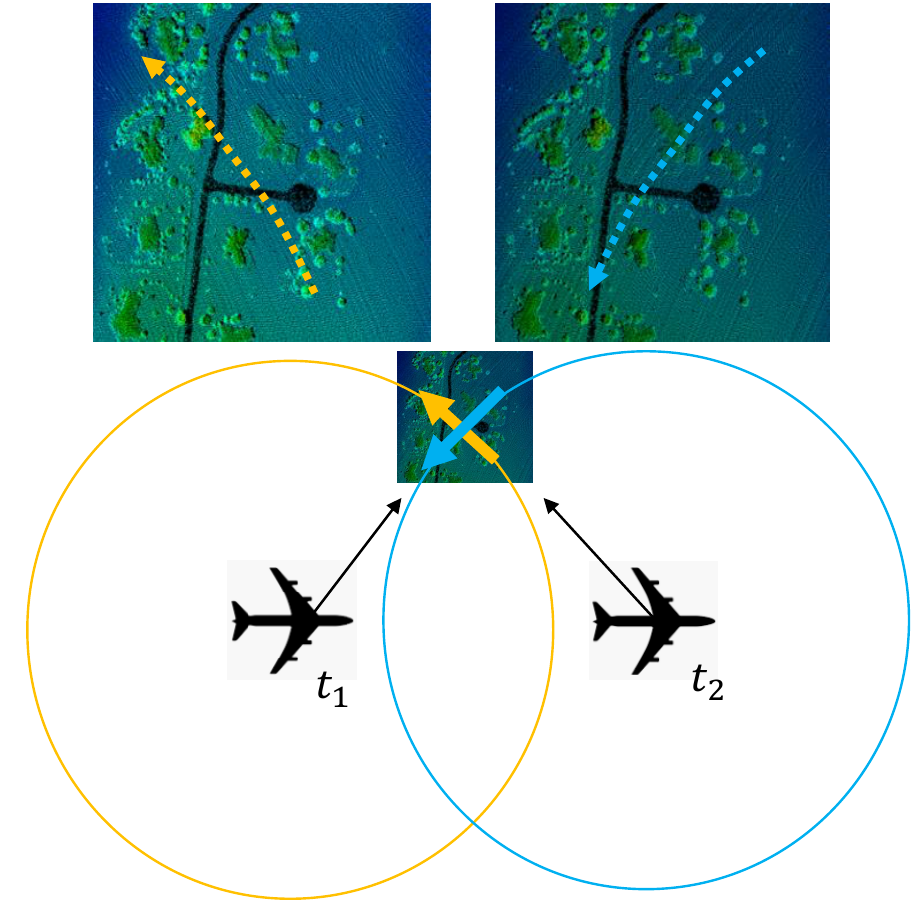
Figure 8. Point cloud from opposite scan direction.